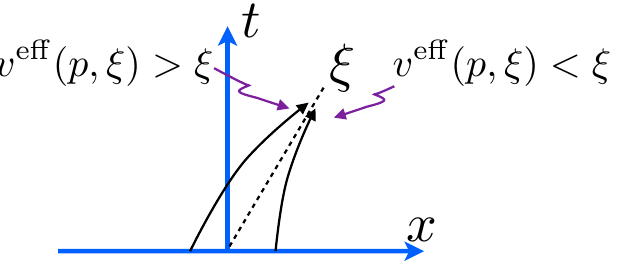
Figure 14: The solution to the partitioning protocol. The state for quasiparticle p is determined by the direction this quasiparticle comes from when it reaches the ray ξ